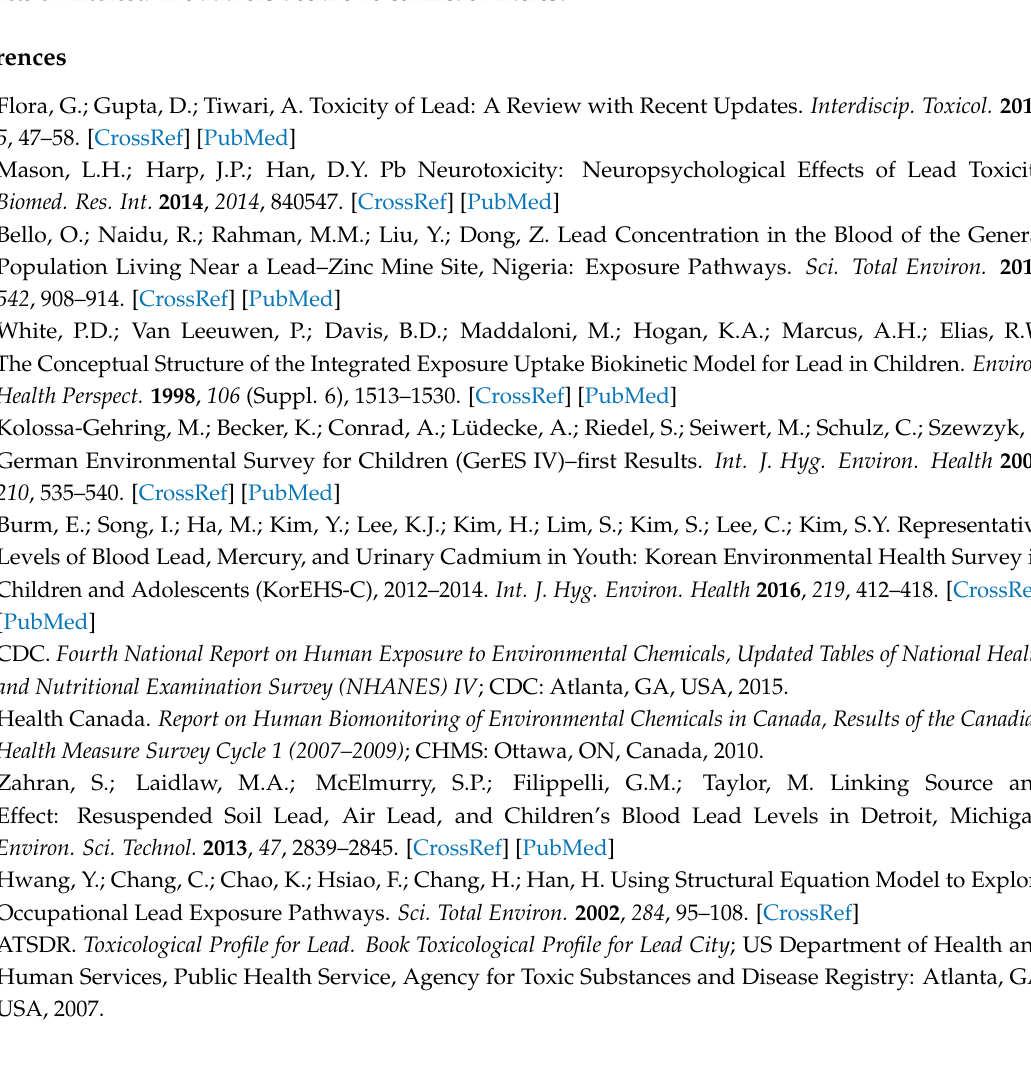
s1, Table S1: Comparisons of the SES variables among the enrolled children with SES variables, the study participants, and no study